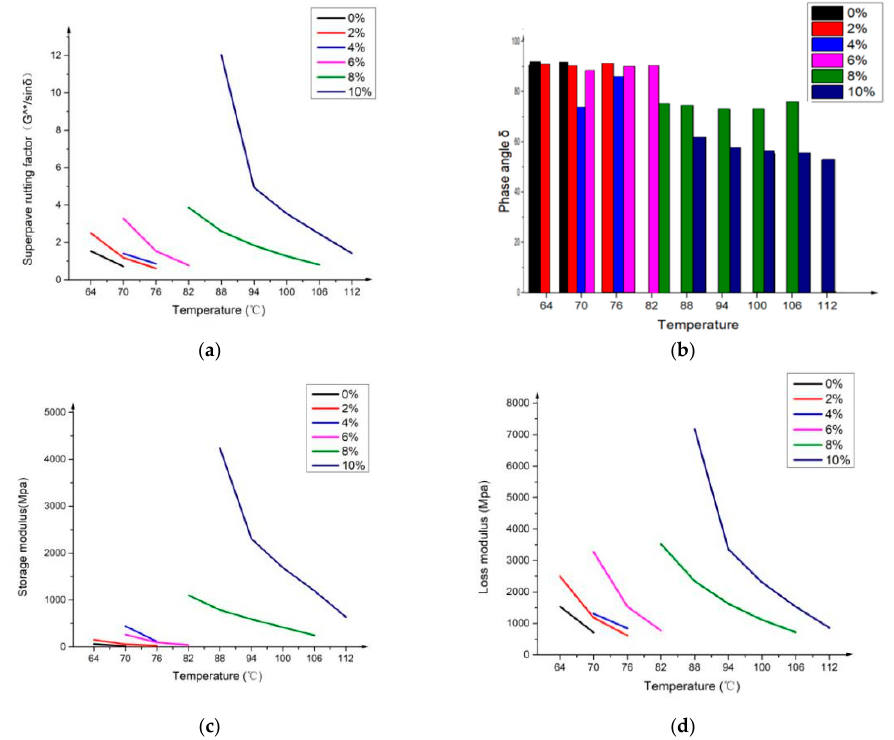
Figure 3. Results of the Superpave rutting factor test: ( a ) rutting factors; ( b ) phase angle; ( c ) storage modulus; and ( d ) loss modulus.